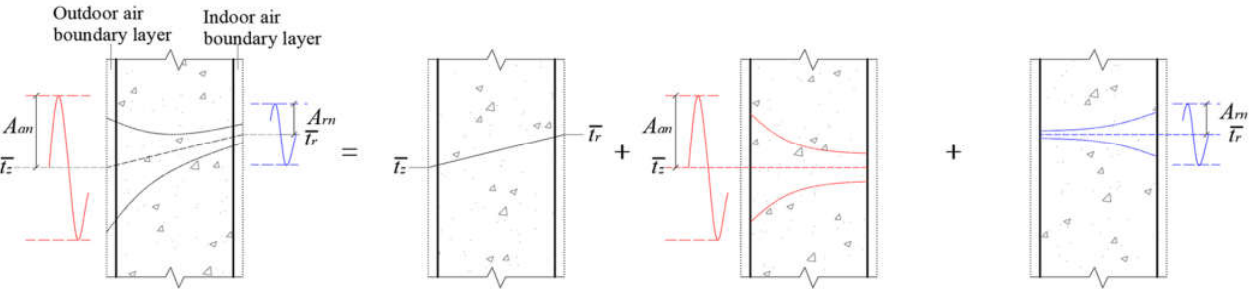
Figure 10. Schematic diagram of heat transfer calculation.